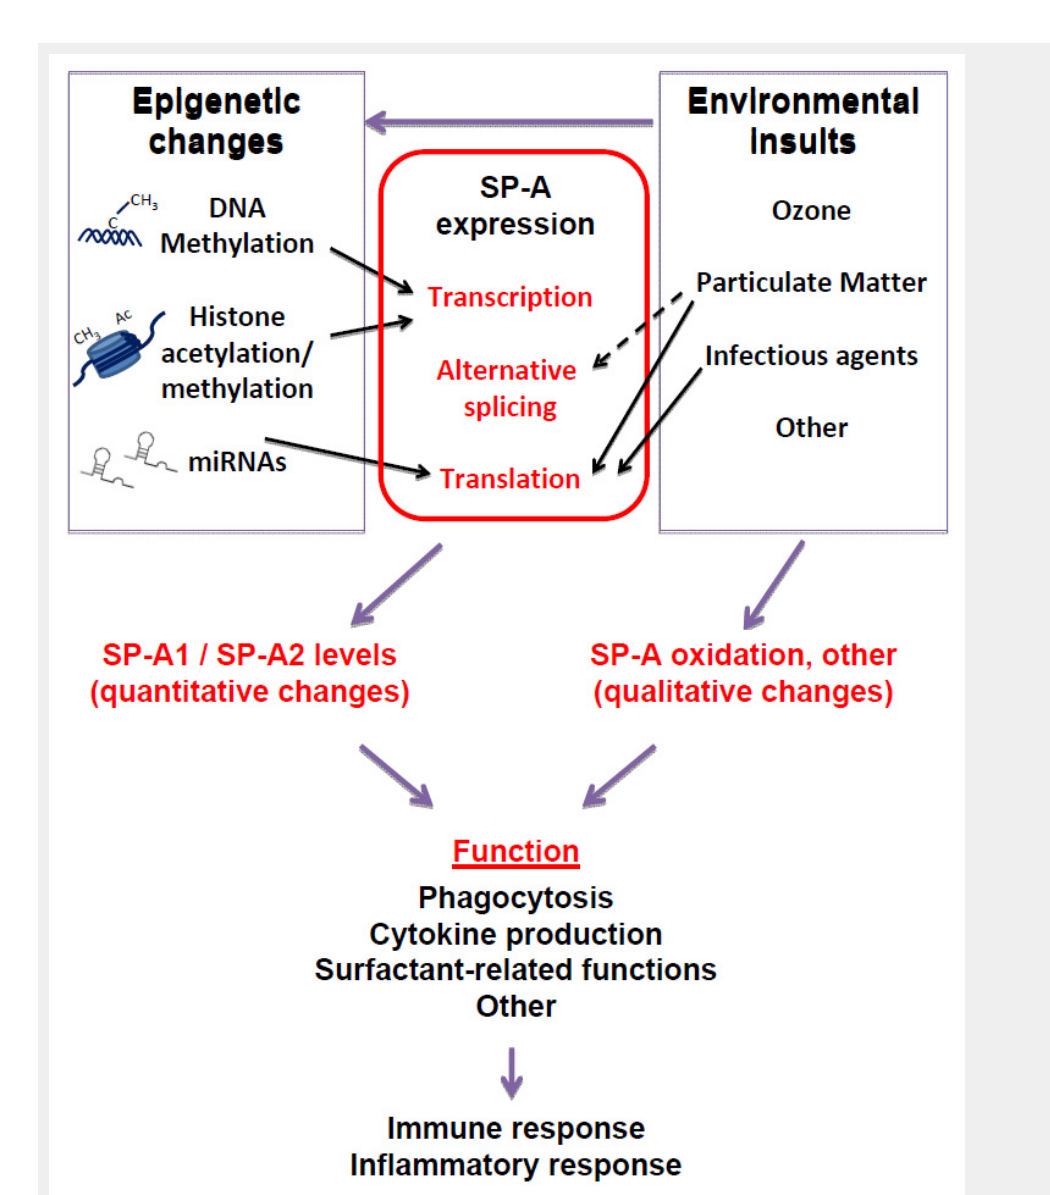
Epigenetics and the environment on SP-A expression and function. The effects of different environmental pollutants on epigenetics have been extensively studied and reported [1–6]. Environmental insults hold the potential to affect SP-A both qualitatively and quantitatively. Epigenetic mechanisms affect SP-A expression by altering transcription including methylation of CpG sites in the SP-A promoters [24, 74], and modifications of histones located in the chromatin of SP-A regulatory sequences [75, 76]), as well as translation efficiency (miRNA-mediated repression [77]). As a result, the relative content of SP-A1 and SP-A2 is affected, resulting in altered immune and inflammatory responses. SP-A is also affected by environmental insults. Oxidation of SP-A is increased after ozone exposure [43, 47], with subsequent effects on innate immunity and inflammatory processes [26, 43, 85]. An effect of particulate matter on alternative splicing of SP-A transcripts (our unpublished data), and on translation may also occur [25]. Particulate matter and infection with RSV affect SP-A levels by altering translation efficiency [25, 83]. Arrows indicate published data; broken arrow indicates preliminary/unpublished